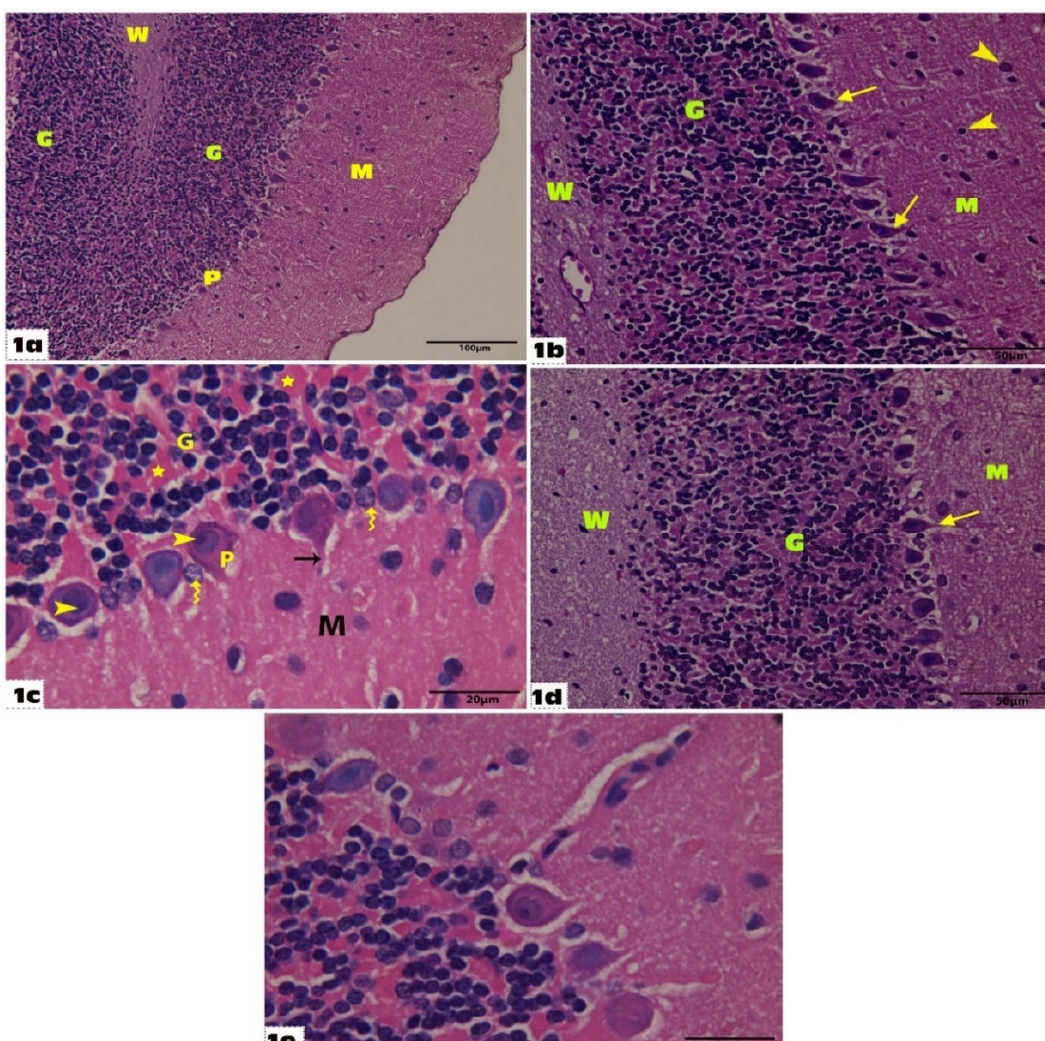
Figure 1. Sections of the cerebellum of the control and Empagliflozin-treated groups (group I and IV): ( a ) Shows the control cerebellar cortex lamination into outer molecular (M), middle Purkinje layer (P), and inner granular (G), and inner white matter of cerebellar medulla (W) (H&E 200). ( b ) Shows the molecular layer (M) has scattered rounded cells (arrow heads) with numerous nerve fibers. Purkinje cells (arrow) arranged in a single row of large pear-shaped cells with vesicular nuclei. The granular layer (G) shows densely packed clumps of cells with small clear non-cellular areas called cerebellar islands (glomeruli) in the control group (H&E 400). ( c ) Shows flask-shaped Purkinje cells (P), which contain well-defined rounded vesicular nuclei and prominent nucleoli (arrow heads) with slightly basophilic cytoplasm,